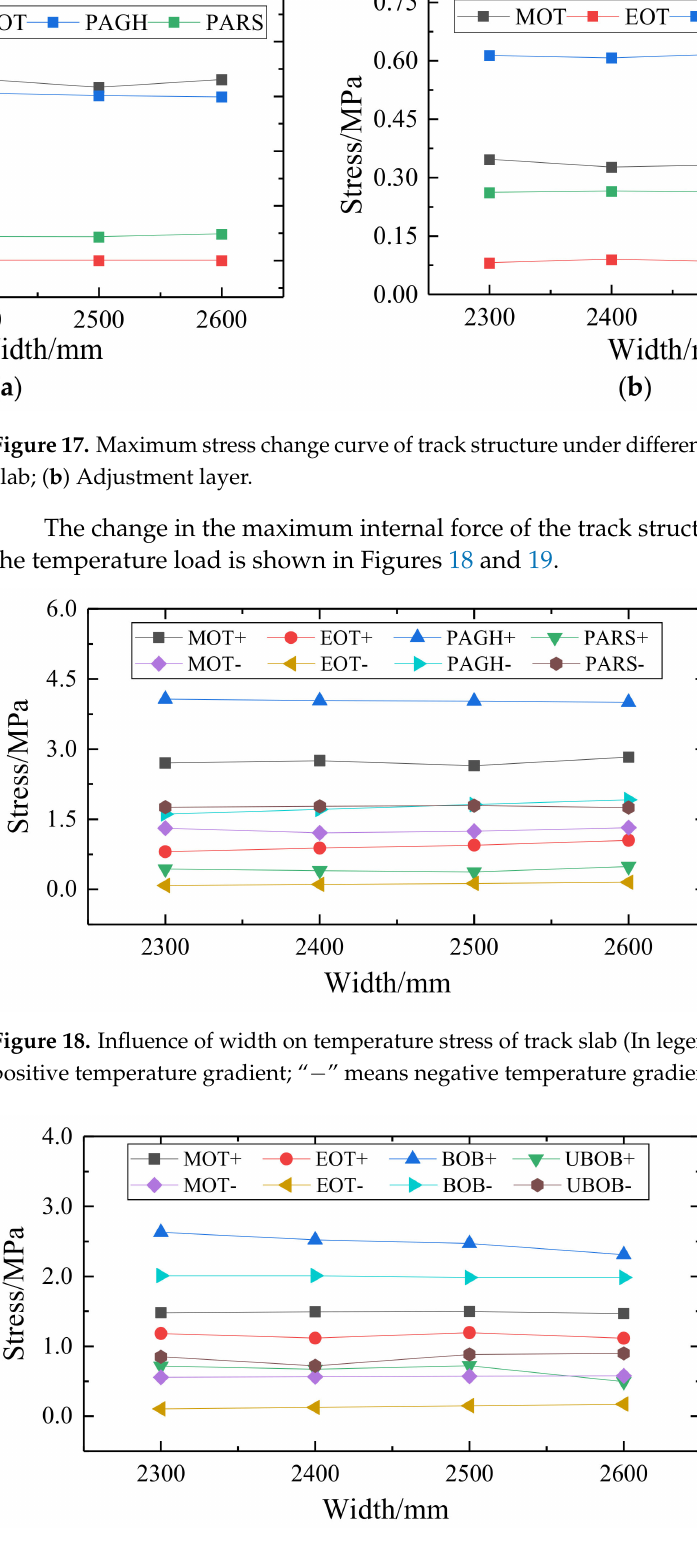
Figure 19. Influence of width on temperature stress of adjustment layer (In legend identification, “+” means positive temperature gradient; “ − ” means negative temperature